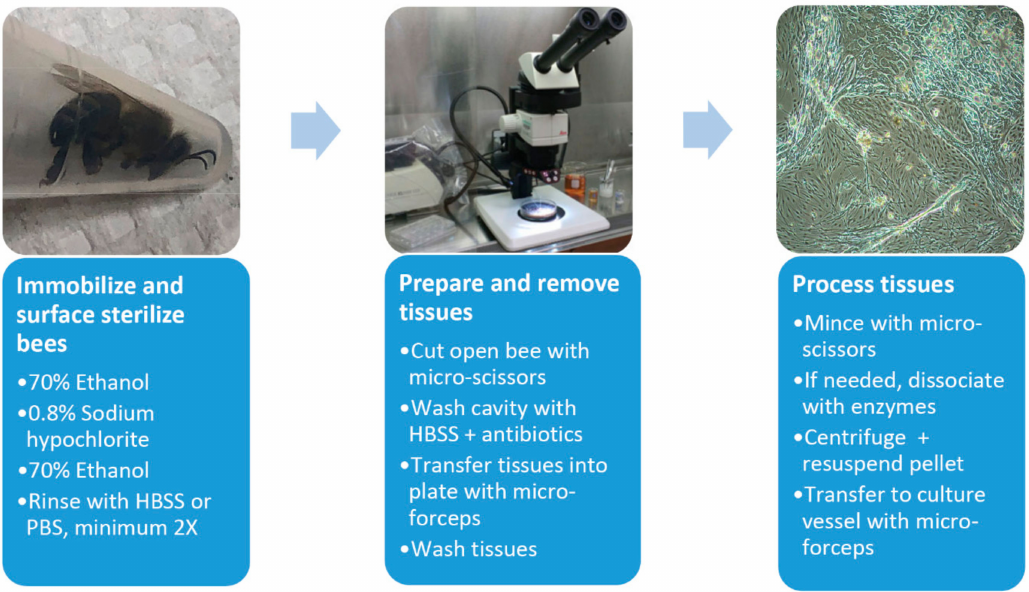
Figure 1. Flow chart for establishment of honey bee-derived cell lines. HBSS, Hanks balanced salt solution. See text for further